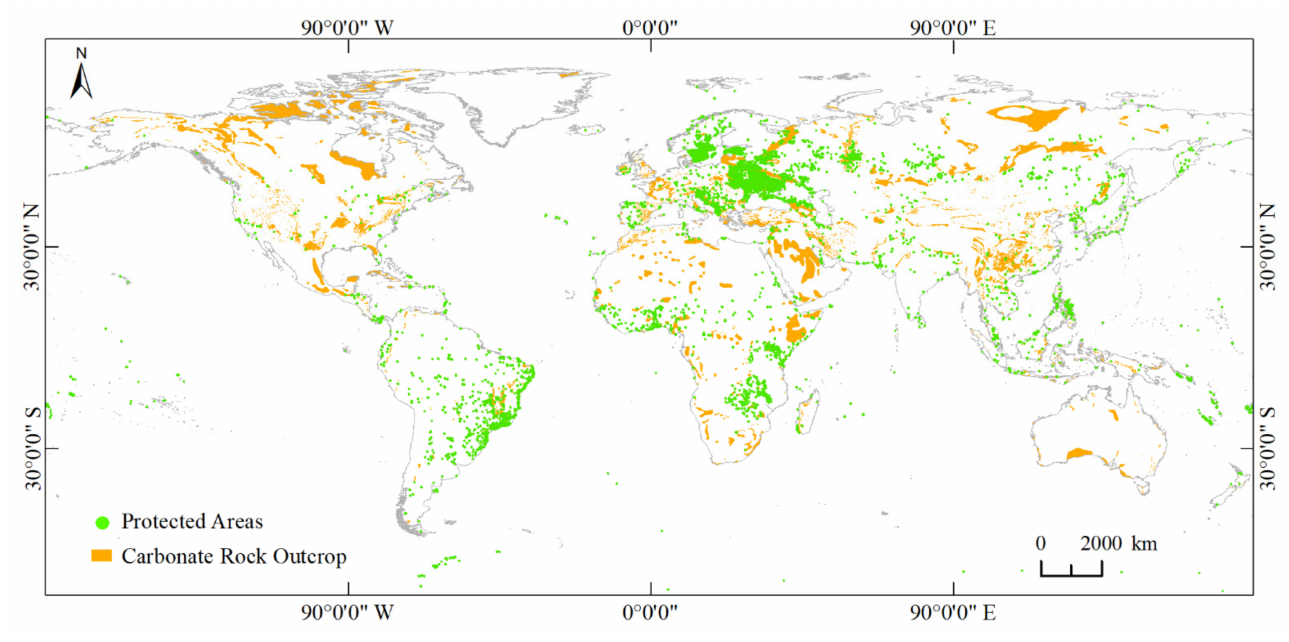
Figure 1. Global distribution of protected areas in karst areas. Protected areas and carbonate rock outcrops are based on data from https://www.protectedplanet.net/en (accessed on 1 April 2022) and https://www.fos.auckland.ac.nz/our_research/karst/index.html (accessed on 1 April